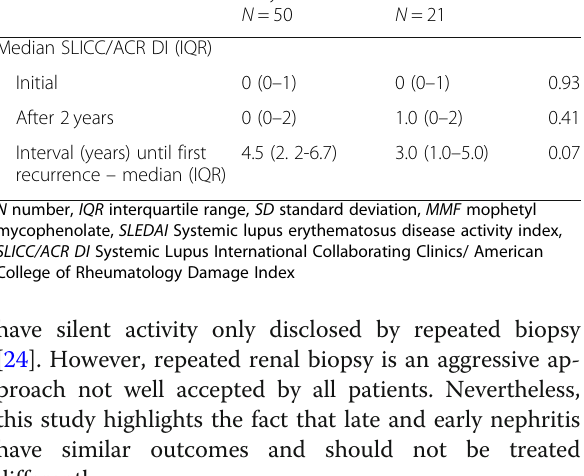
Table 2 Comparative analysis of main characteristics and treatment response in Systemic Lupus Erythematosus (SLE) patients with early and late onset nephritis